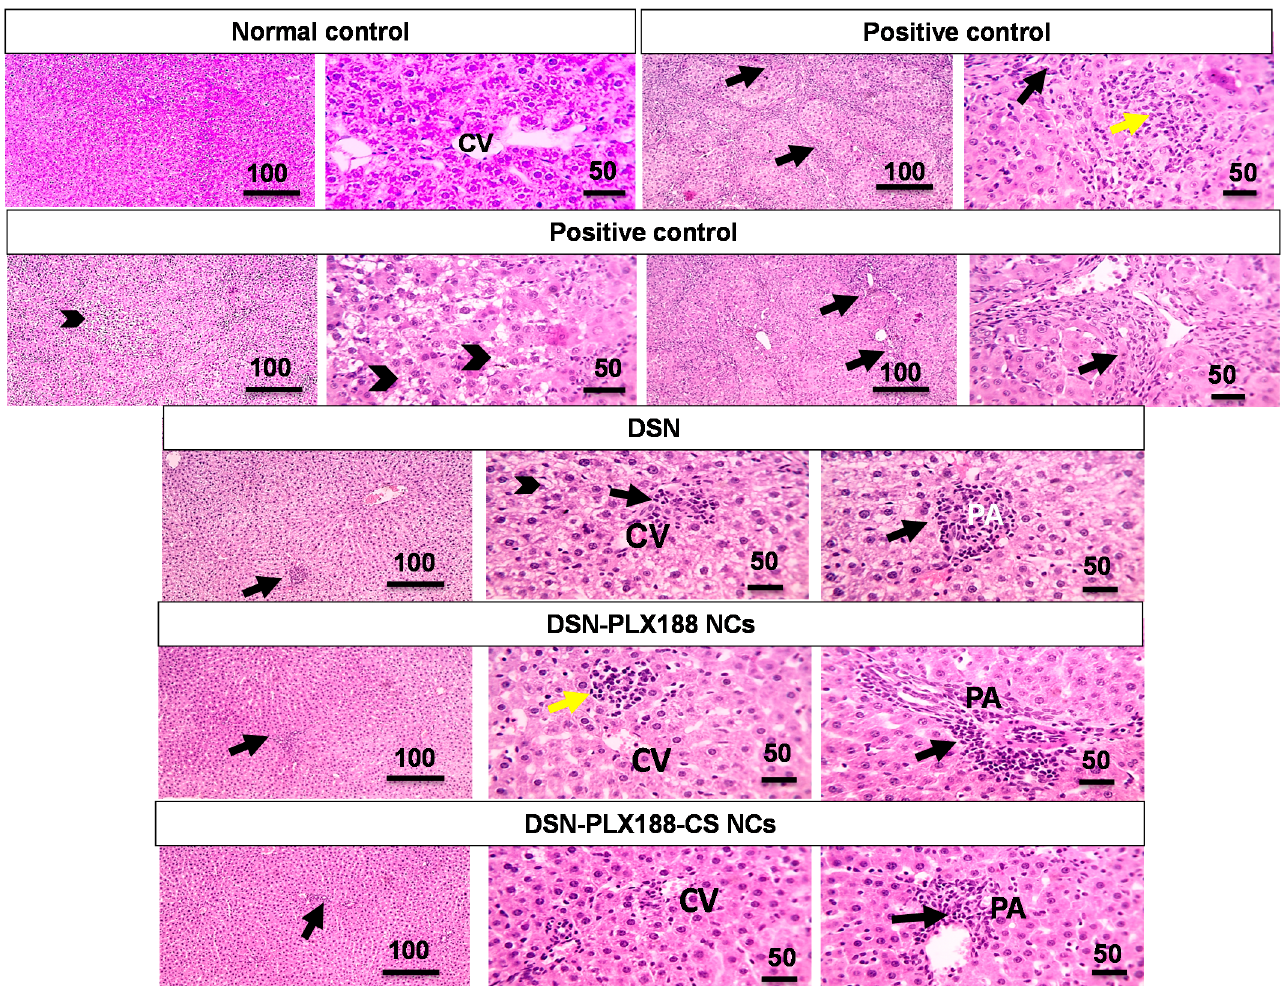
Figure 8. Microscopic pictures of hematoxylin and eosin (H&E)-stained hepatic sections of the different groups following the post-treatment regimen. Low magnification x: 100 bar 100 µ m and high magnification x: 400 bar 50 µ m. CV, central vein; PA, portal area. In the positive control: portal fibrosis and inflammation (black arrows); lobular inflammation (yellow arrow); hydropic degeneration in hepatocytes (arrowheads). In the DSN-post-treated group: lobular inflammation close to the central vein (black arrow); portal inflammation (black arrow); hydropic degeneration in the hepatocytes (arrowheads). In the DSN–PLX188-NC-post-treated group: lobular inflammation (yellow arrow); portal inflammation (black arrow). In